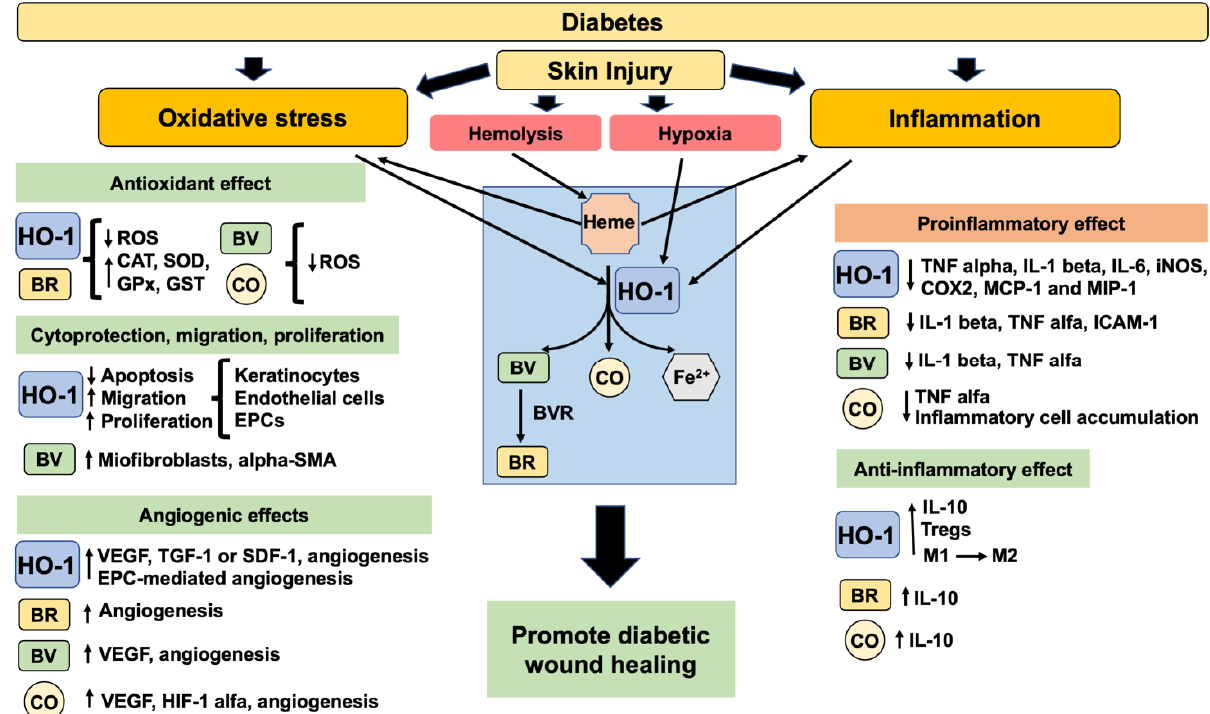
Figure 2. The beneficial role of HO ‐ 1 and its enzymatic products in promoting diabetic wound heal ‐